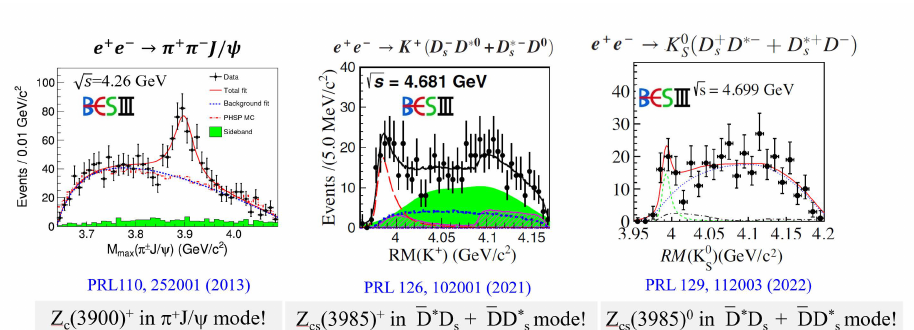
Figure 7. The Z c (3900) (left panel, [52]), Z cs (3985) + (middle panel, [58]), and Z cs (3985) 0 (right panel, [59]) signals observed in BESIII